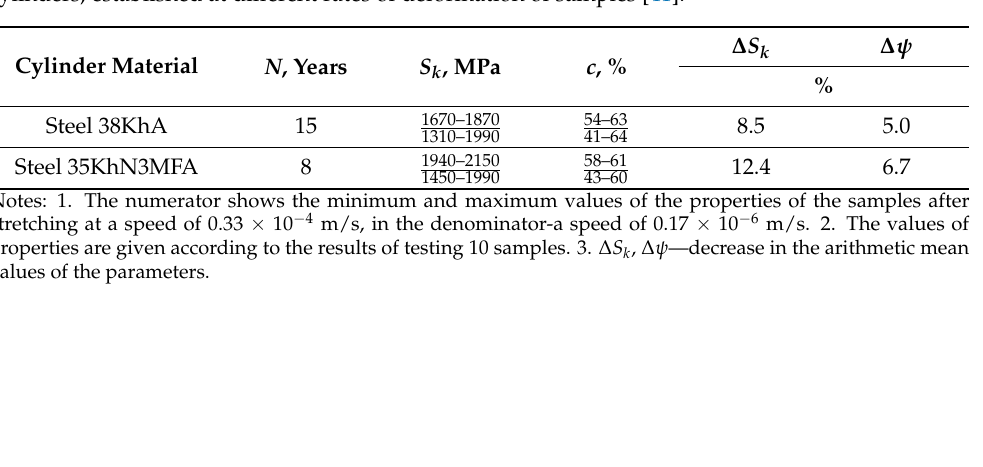
Table 4. Values of true breaking stress S k and relative constriction ψ of materials used in hydrogen cylinders, established at different rates of deformation of samples